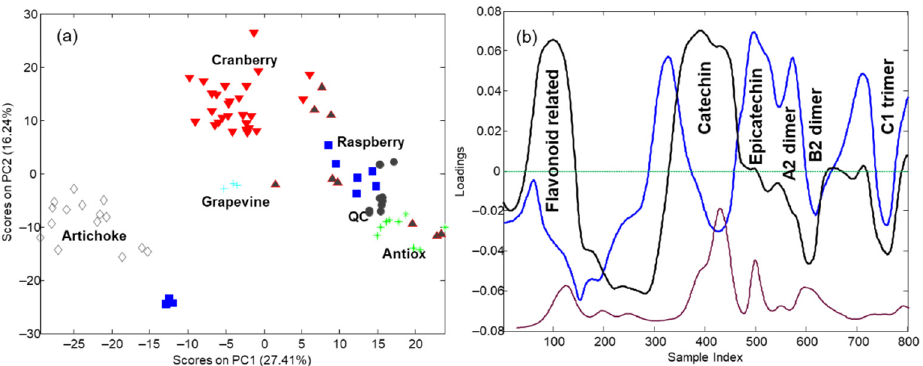
Figure 4. Characterization of nutraceuticals and dietary supplements by PCA using the chromatographic fingerprints in the time range 6.2–16 min as the data. ( a ) Scatter plot of scores of PC1 vs. PC2 and ( b ) plot of loadings of PC1 and PC2. PC assignation: black = PC1 and blue = PC2. Sample assignation: see Figure 3.